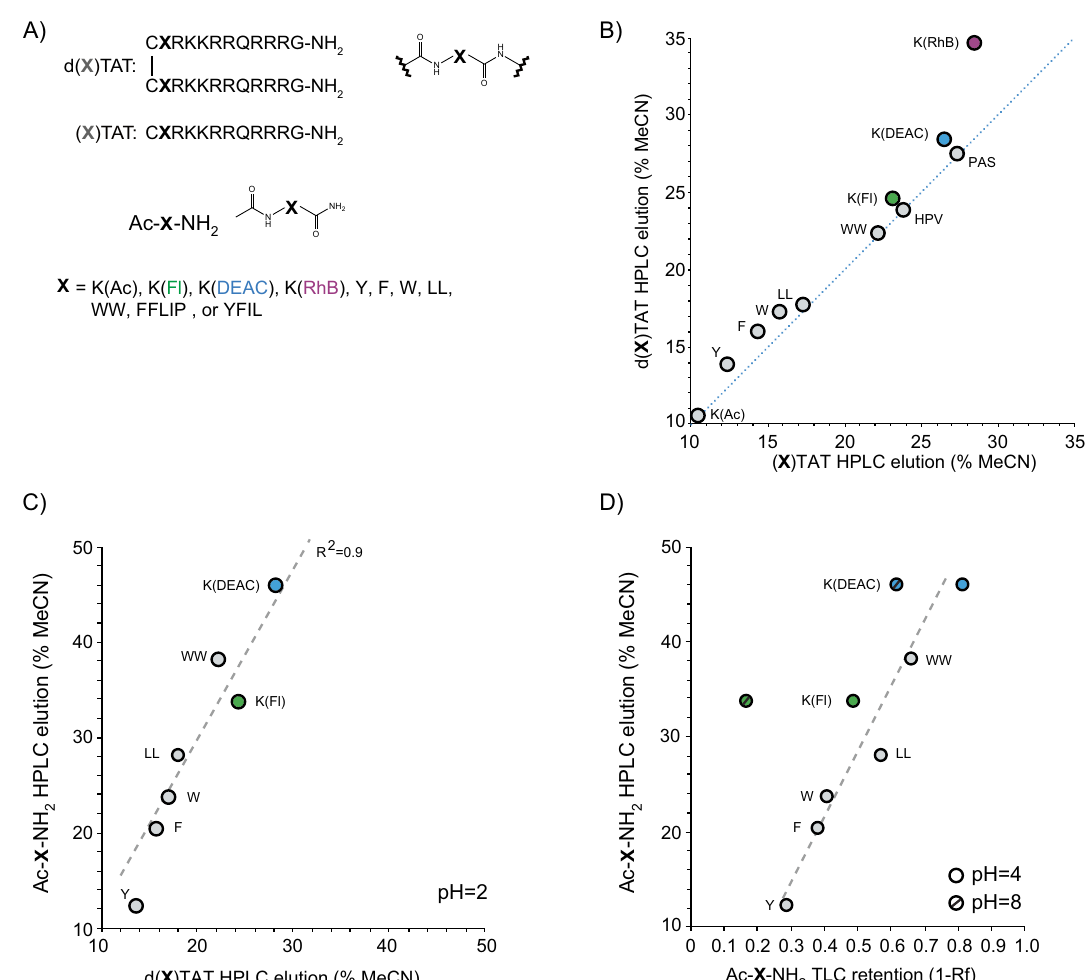
Figure 1. d(X)TAT peptides and their corresponding hydrophobicity. ( A ) General structure of the d(X) TAT constructs and of the Ac-X-NH2 analogs. X consists of the lysine residue labeled with on its side chain with an acetyl group (Ac), carboxyfluorescein (Fl), 7-diethylaminocoumarin-3-carboxylic acid, or rhodamine B. Alternatively, X consists of the residues tyrosine (Y), phenylalanine (F), tryptophan (W), or the peptide sequences LL, WW, FFLIP, or YFIL (where L is leucine, P proline, and I isoleucine). ( B ) Relative hydrophobicity of (X)TAT (monomeric peptide) and d(X)TAT (dimeric peptide formed by disulfide bond formation) based on C18 reverse phase HPLC. The percentage of acetonitrile at which the respective peptide elutes from the column is used as a measure of hydrophobicity. ( C ) Correlation between the hydrophobicity of d(X)TAT and corresponding Ac-X-NH2 analogs, as determined by C18 reverse phase HPLC. ( D ) Correlation between the hydrophobicity of Ac-X-NH2 determined by reverse phase HPLC (pH 2), or by reverse phase TLC (1-Rf displayed) at either pH 4 or pH 8. The TLC retention of Ac-X-NH2 with X = Y, F, W, LL, WW is pH independent and only results for pH 4 are